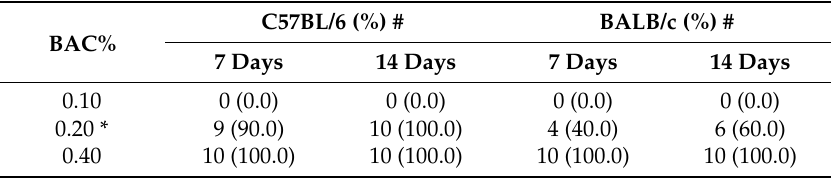
Table 1. Prevalence of corneal neovascularization in the two strains of mice.